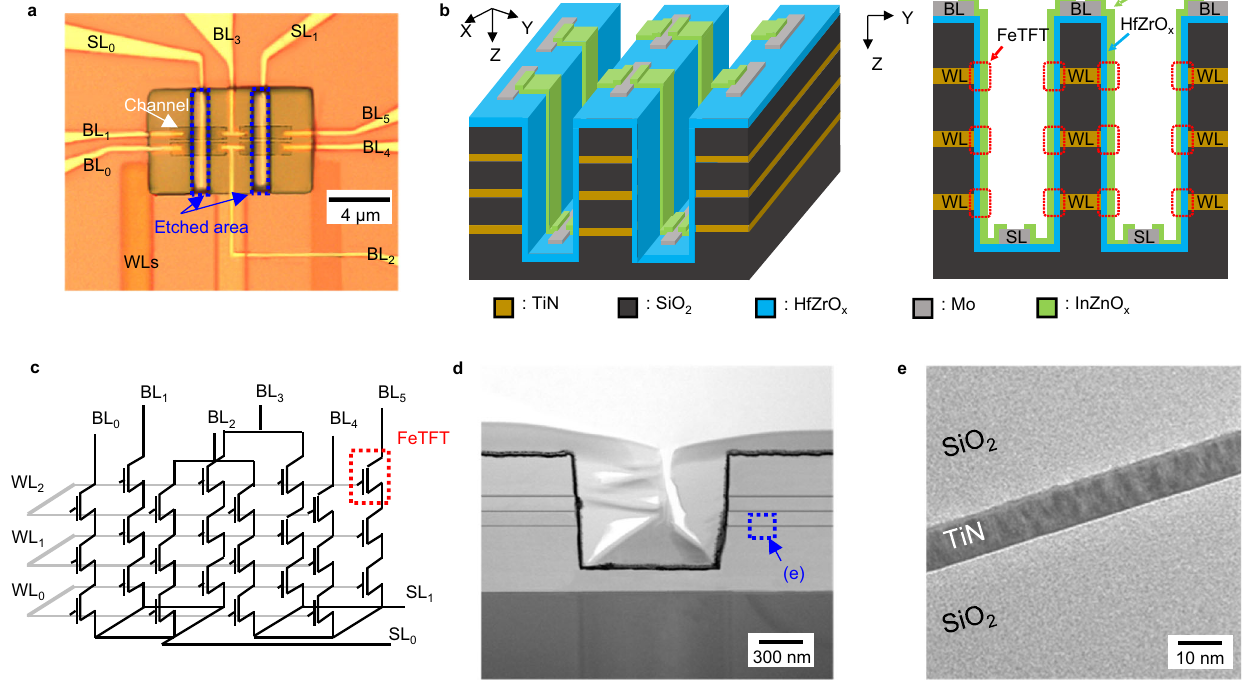
Fig. 1 | Demonstration of 3D ferroelectric NAND (FeNAND) using nanoscale vertical ferroelectric thin- fi lm transistors (FeTFTs). a Optical image of the 3D FeNAND using nanoscale vertical FeTFTs. b Schematic illustration of 3D FeNAND (left) and cross-sectional view of 3D FeNAND with an effective channel area of